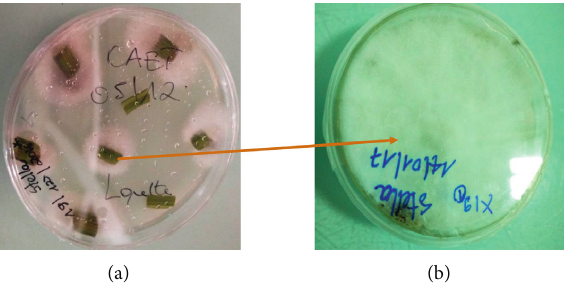
Figure 1: Culture of leave fragments of T. catappa on potato dextrose agar (PDA) plates showing emerging mycelia of endo- phytic fungi (a) after 6 days of incubation and the resulting pure culture of that fungus obtained after subculture on a new PDA plate (b). The culture of leaves from T. catappa is an example to illustrate the isolation of endophytes from various parts of the plant. Similar cultures were done for the other parts of T. catappa to isolate the different endophytes extracts reported in Table